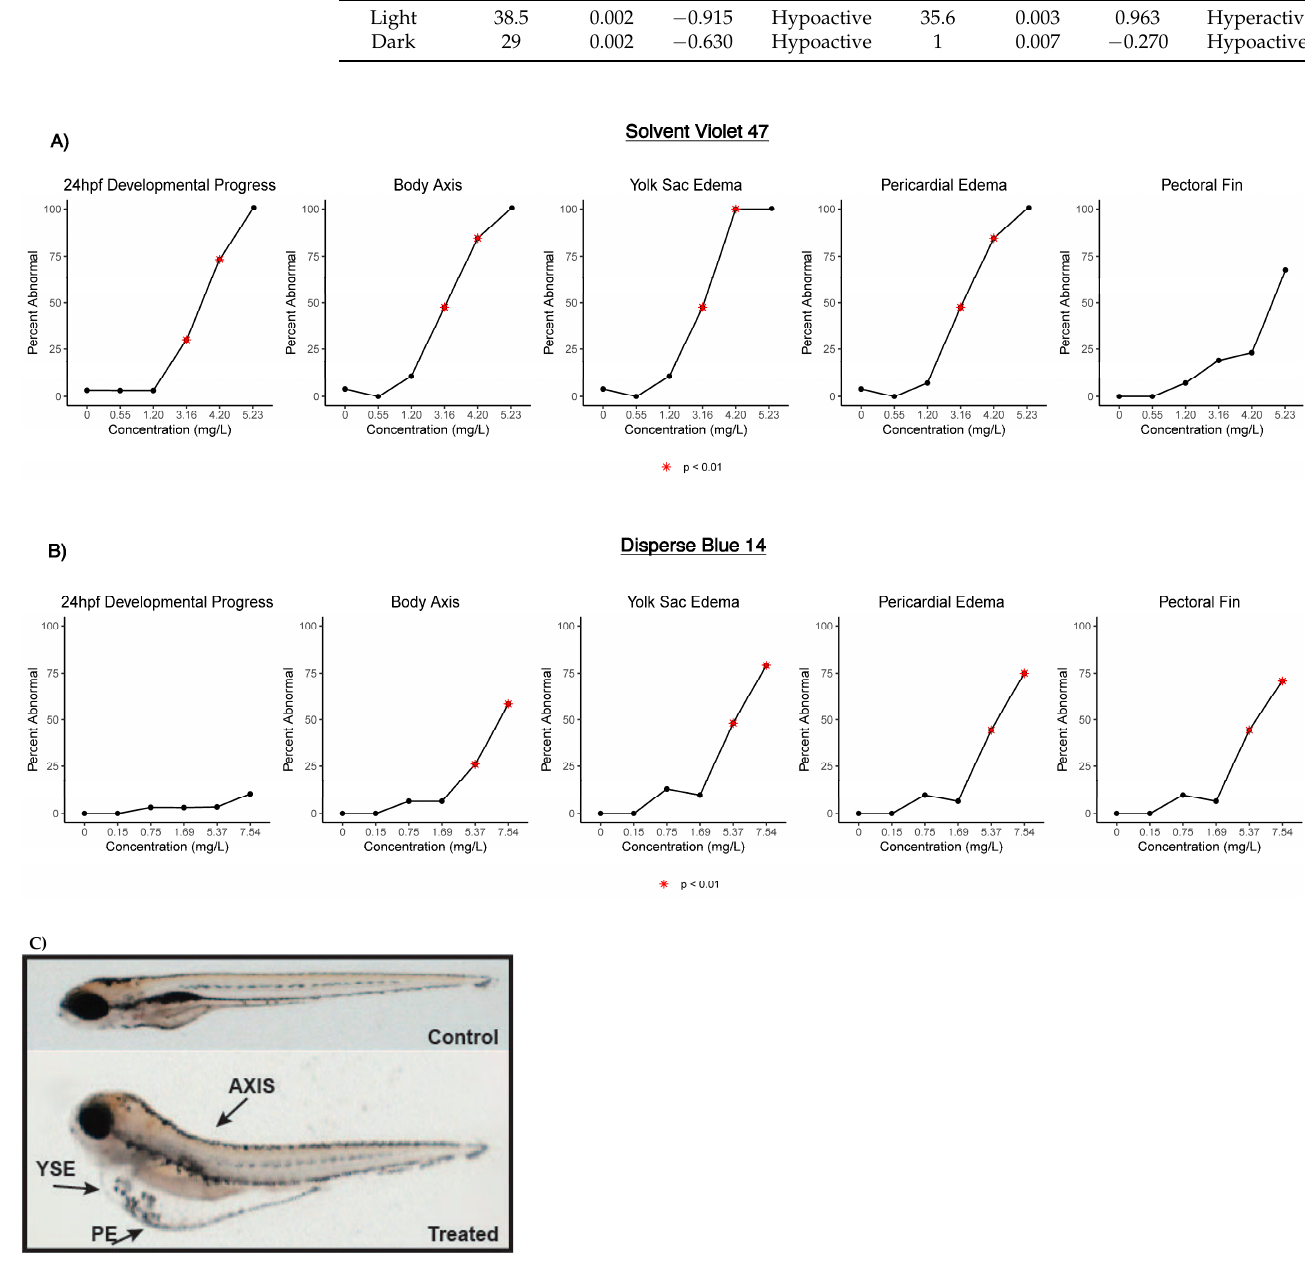
Figure 2. Summary of affected and unaffected selected morphological endpoints in ( A ) Solvent Violet 47 and ( B ) Disperse Blue 14 treatment groups. The figure shows the percentage of embryos per concentration of dye. * Indicates statistical significance ( p < 0.01) against the control (0 mg/L); ( C ) representative endpoints assessed in embryos exposed to the smoke